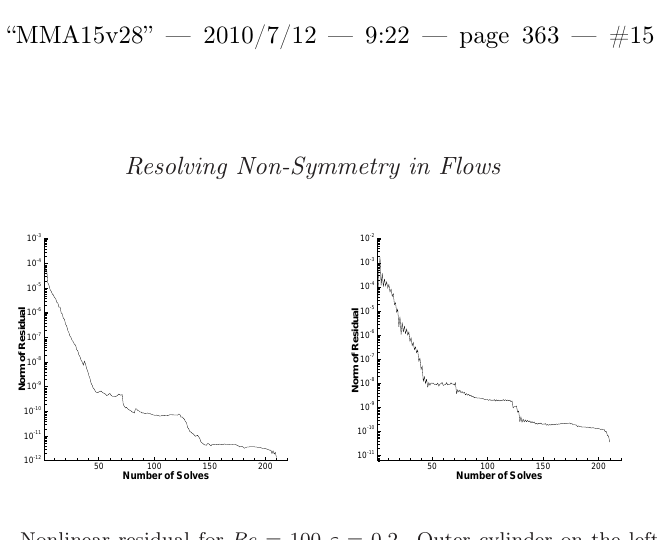
tube at Re = 160 is studied for two different angle of attack, α , values. Outcome of the analysis with α = 0 o is given in figure 10.